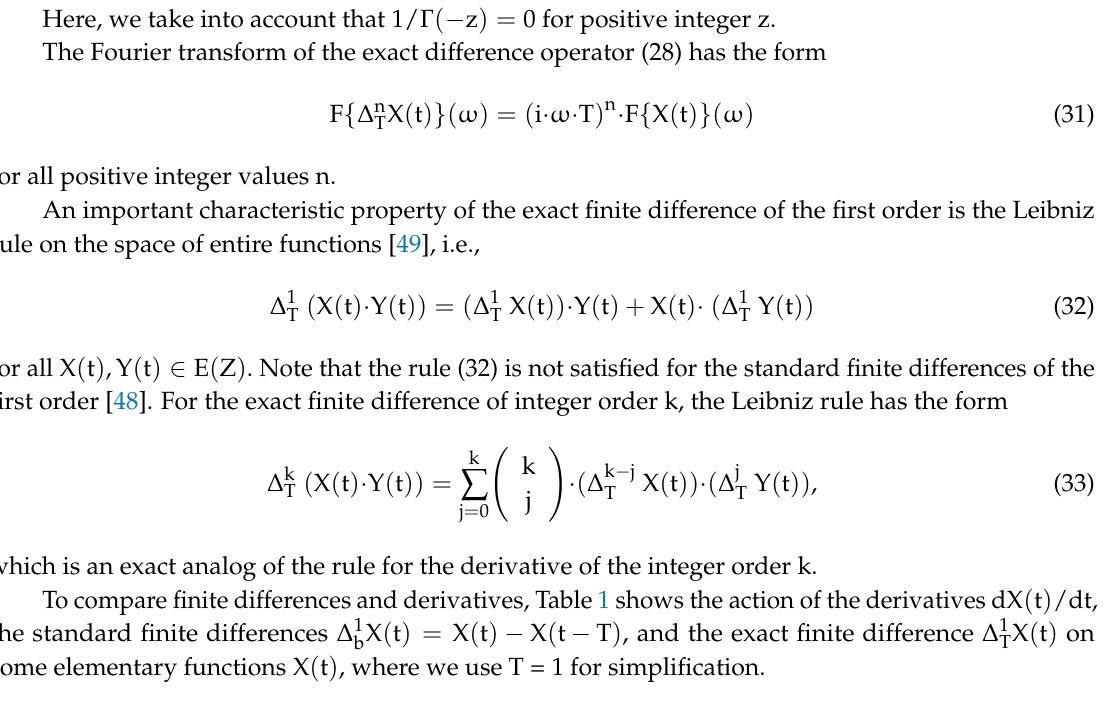
Table 1. The action of derivatives and standard and exact finite differences on some elementary